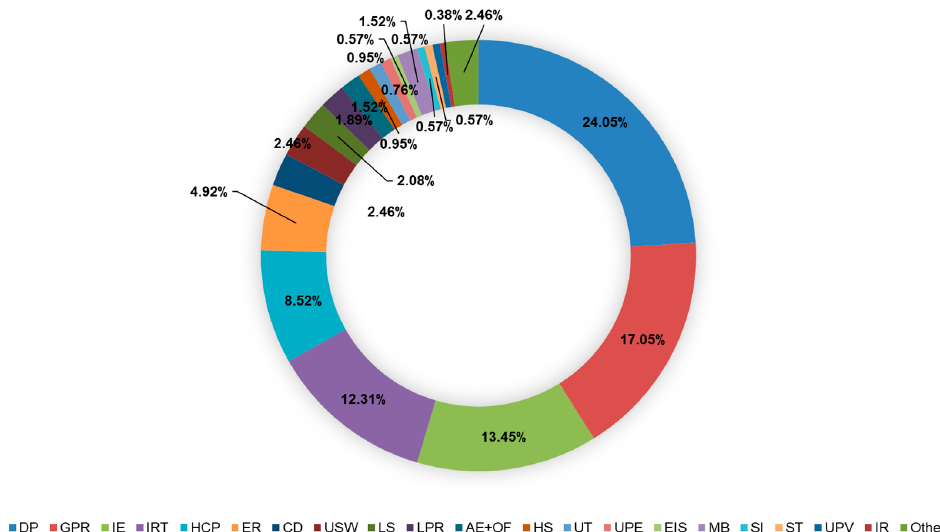
Figure 14. Distribution of the utilized NDTs in the CBD_NDT domain.